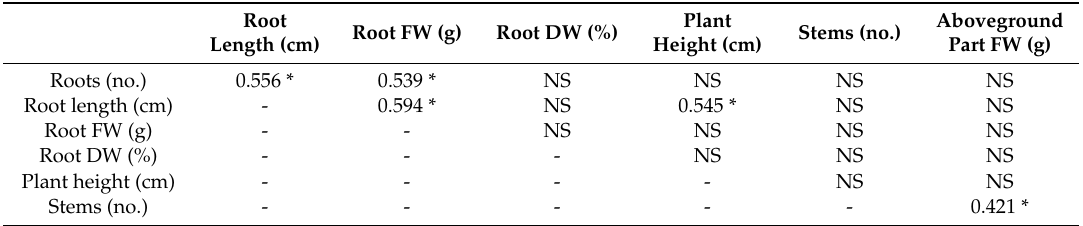
Correlation coe ffi cients between analyzed features, irrespective of the medium and biostimulator